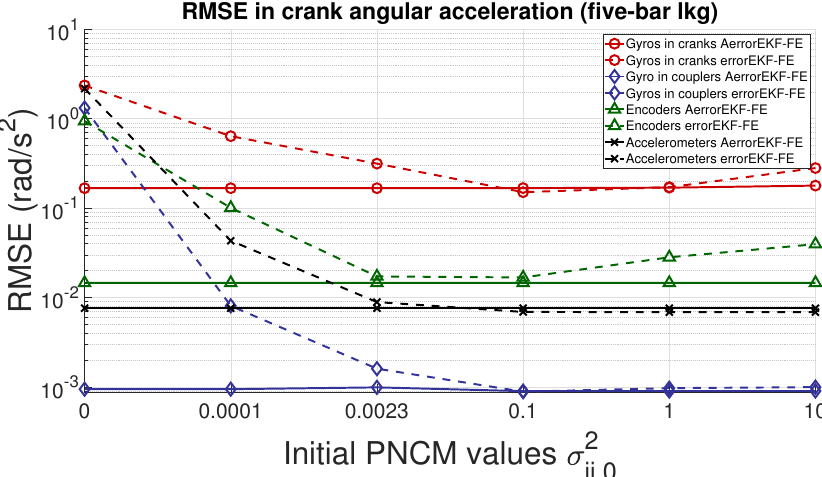
Figure 13. RMSE of the norm of the two crank angular accelerations provided by the observers for the five-bar linkage.